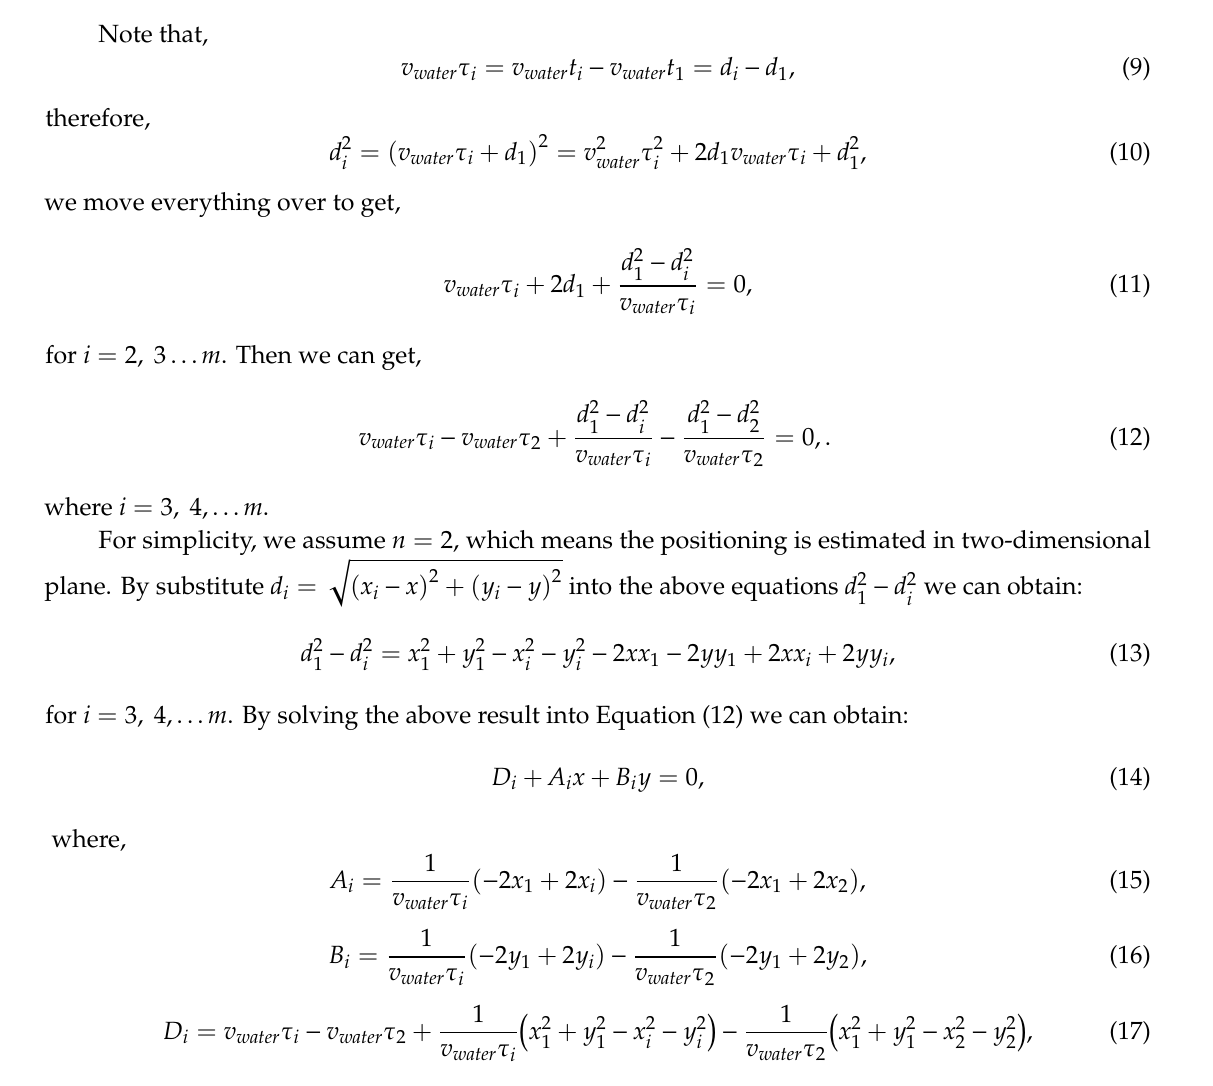
Figure 3. Time di ff erence of arrival (TDOA) in 2-dimension underwater plane (the yellow area is the location of the acoustic source).